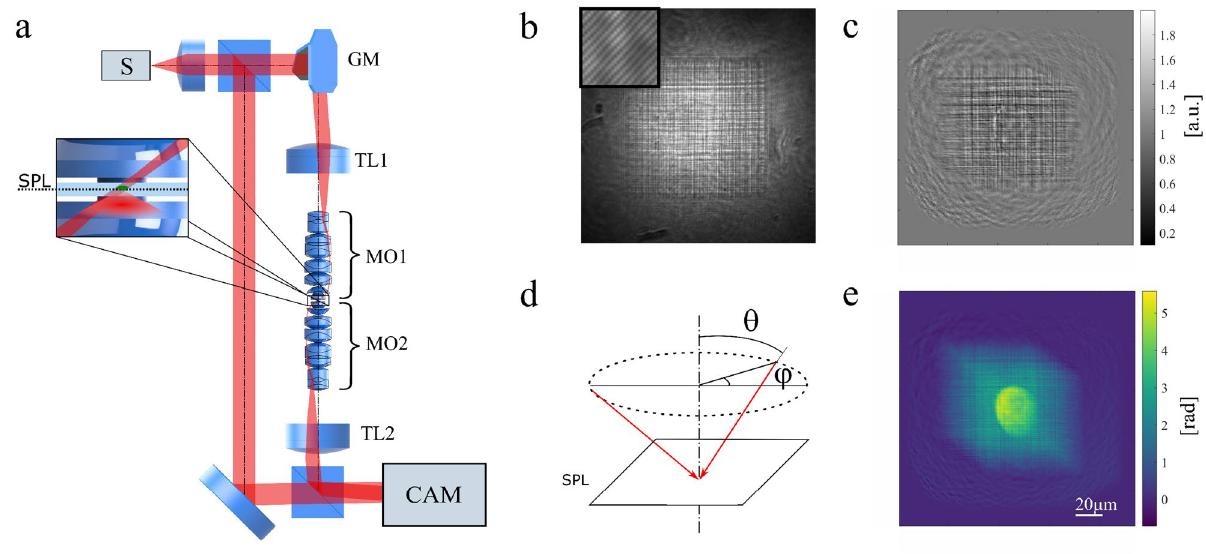
Figure 3. ( a ) Mach-Zehnder-based TPM measurement system. S, light source; GM, galvo system; TL1 and TL2, tube lenses; MO1 and MO2; microscope objective; SPL, sample plane; CAM, camera; ( b ) hologram acquired at axial illumination of the sample; ( c ) amplitude of a projection at ϕ = 304 scenario used in the measurement. Rotation angle: ϕ , zenith angle: θ = 47